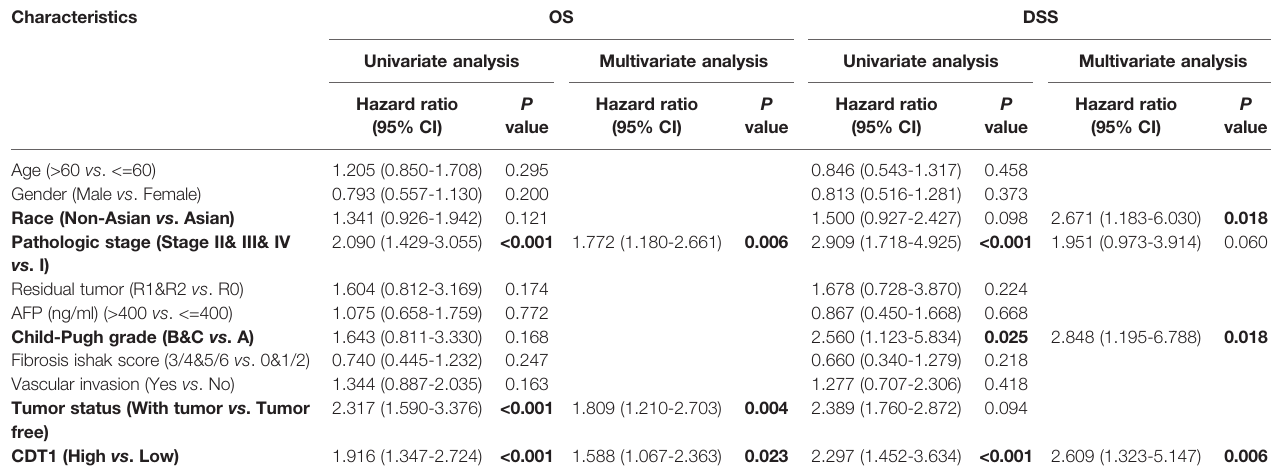
TABLE 2 | Cox regression analyses of variables for OS and DSS in LIHC patients.